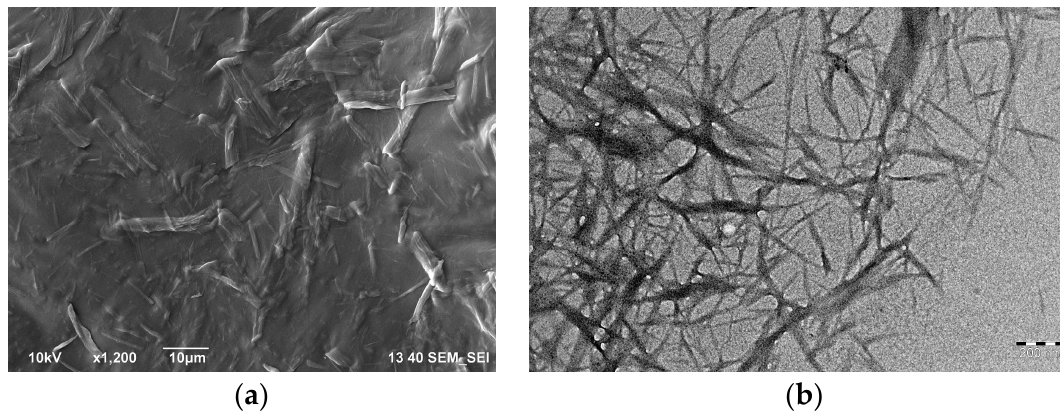
Figure 1. ( a ) SEM micrograph of cellulose nanofibrils. Scale bar, 10 µm; ( b ) TEM micrograph of cellulose nanofibrils. Scale bar, 200 nm.